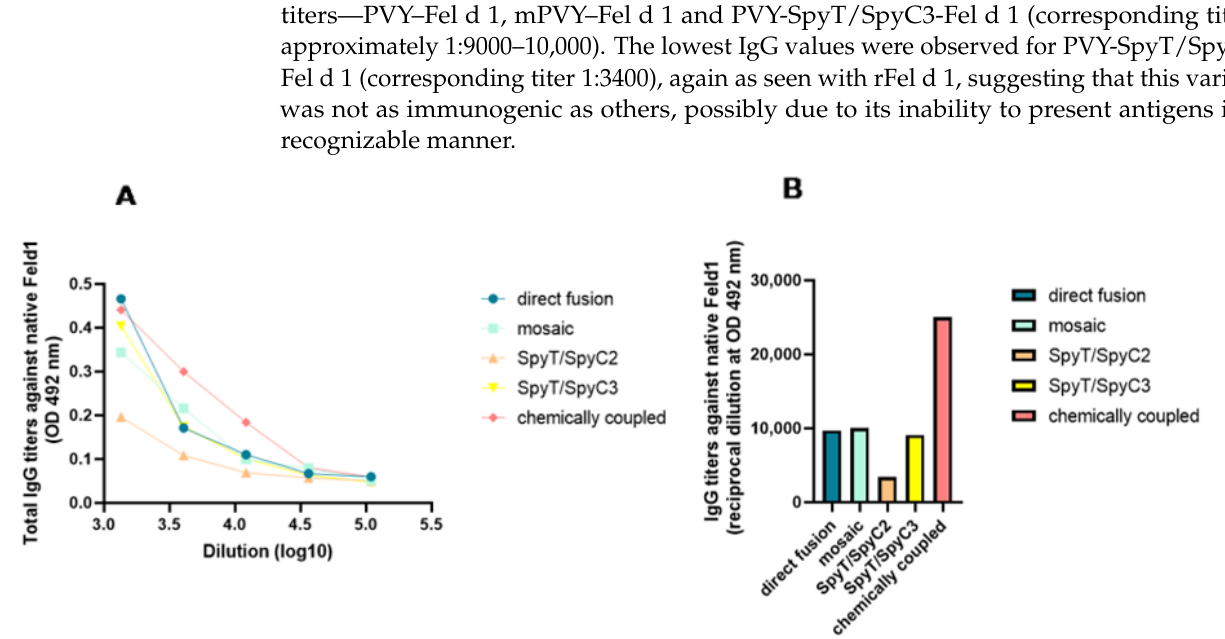
Figure 10. PVY–Fel d 1 variants induced antibodies against Fel d 1 ELISA analysis using native Feld1. ( A , B )—Fel d 1-specific IgG titers against native Feld1 for the groups vaccinated with PVY–Fel d 1 vaccine variants on Day 42 measured at OD 492 . One representative experiment was performed.